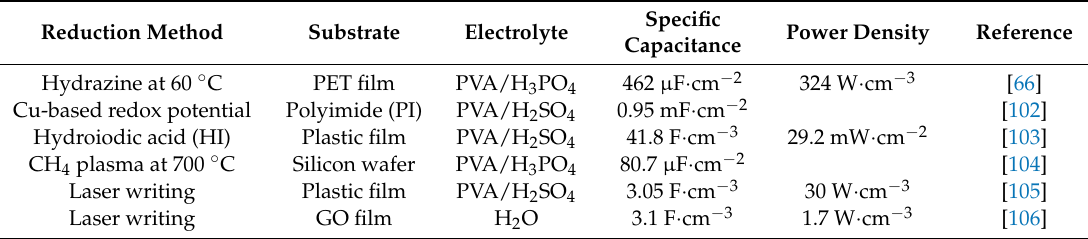
Table 1. Summary of various graphene-based planar micro-supercapacitors derived from graphene oxide.